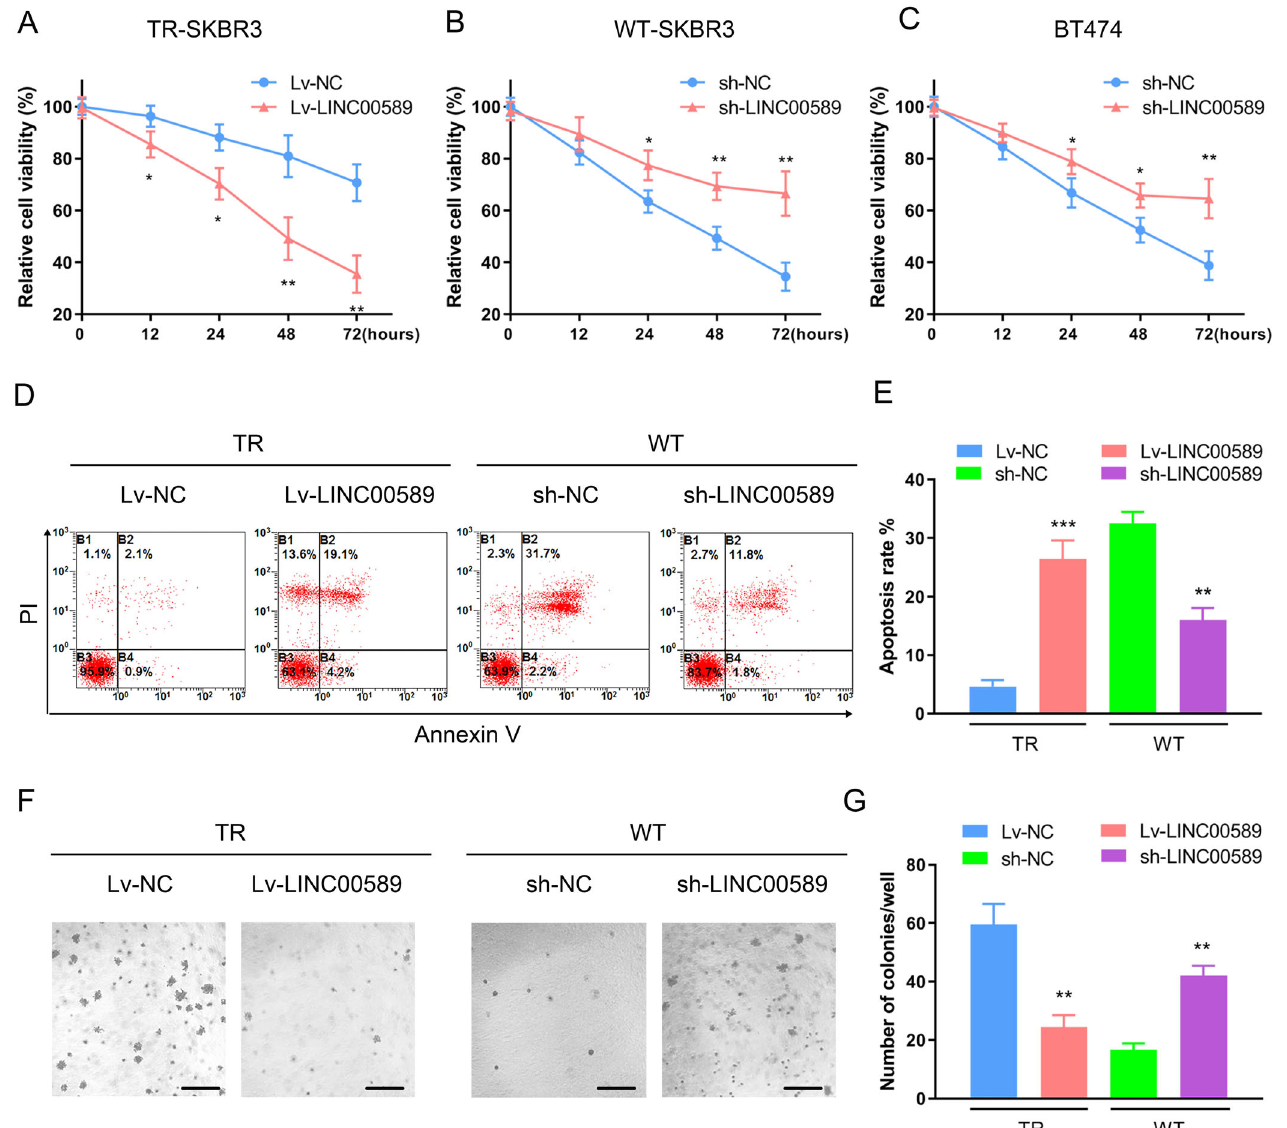
Fig. 2 LINC00589 promotes the sensitivity of breast cancer cells to trastuzumab and inhibits anchorage-independent growth. A – C TR SKBR3 cells were infected with NC or LINC00589 -overexpression lentivirus and treated with 25 μ g/ml trastuzumab. WT SKBR3 and BT474 cells were infected with sh-NC or sh- LINC00589 lentivirus and treated with 5 μ g/ml trastuzumab treatment. The relative cell viabilities were determined by CCK-8 assays at the indicated times. D , E TR and WT SKBR3 cells were infected with overexpression or shRNA lentiviruses and then were treated with 25 μ g/ml trastuzumab or 5 μ g/ml trastuzumab for 48 h, followed by FITC-conjugated annexin V and PE-labeled PI staining. The apoptosis rate was analyzed by fl ow cytometry. F , G TR or WT SKBR3 cells were cultured in soft agar for 21 days after trastuzumab treatment and then subjected to crystal violet staining. The clones were observed, and the number of clones for each sample was calculated. Scale bar 100 μ m. Data are represented as the mean ± SD of three replicates or are representative of three independent experiments. Two-way ANOVA were used to analyze the data in ( A – C ), and two-tailed t test was used to analyze the data in ( E , G ). * P < 0.05, ** P < 0.01, and *** P < 0.001 versus negative control